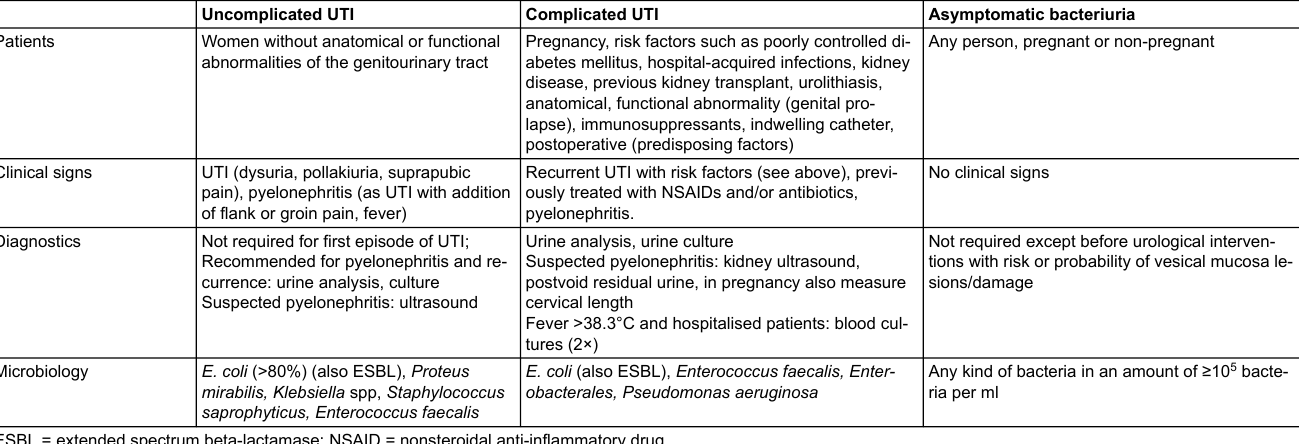
Table 2: Categories of